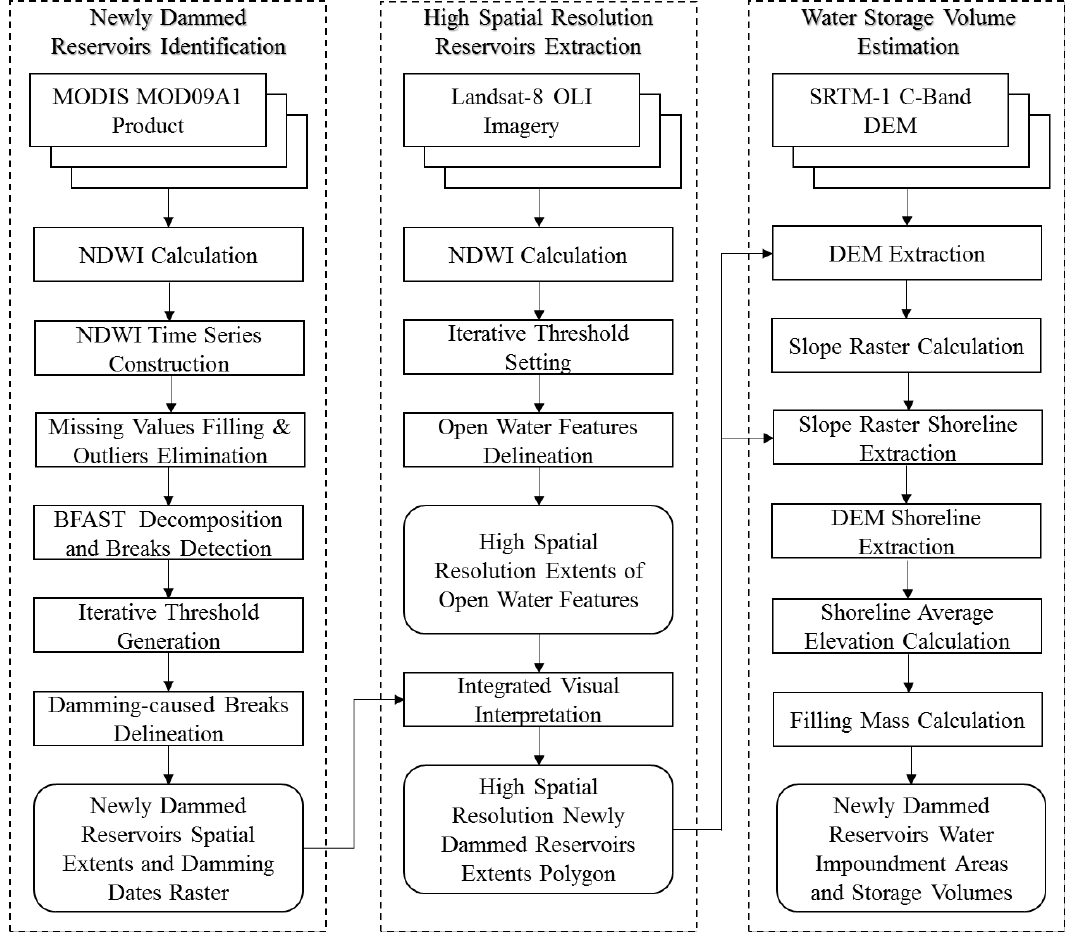
Figure 2. Schematic flowchart of the methodology, including identification of newly dammed reservoirs, extraction of high spatial-resolution reservoirs and estimation of reservoir water volume.